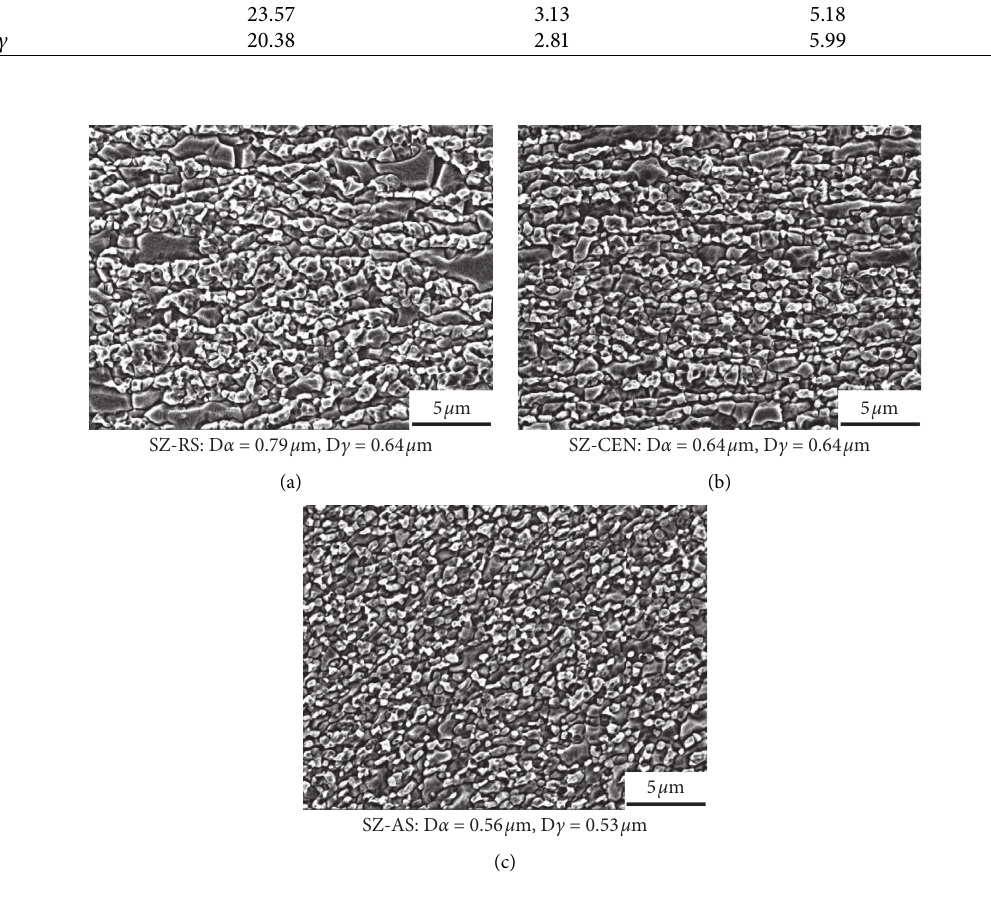
Figure 11: The SEM images and corresponding grain sizes in SZ of the joint welded at 350rpm (electroetched with oxalic acid solution): (a) in the retreating side, (b) in the centre, and (c) in the advancing